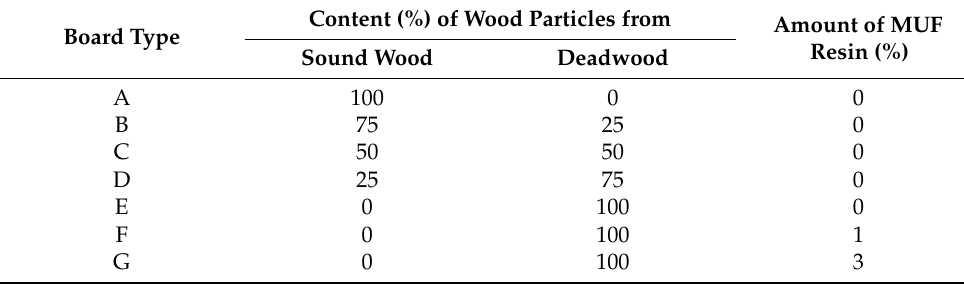
Figure 3. The formed particle mat ( a ) and hydraulic laboratory press ( b ). Table 2. Manufacturing parameters of particleboards. Table 2. Manufacturing parameters of